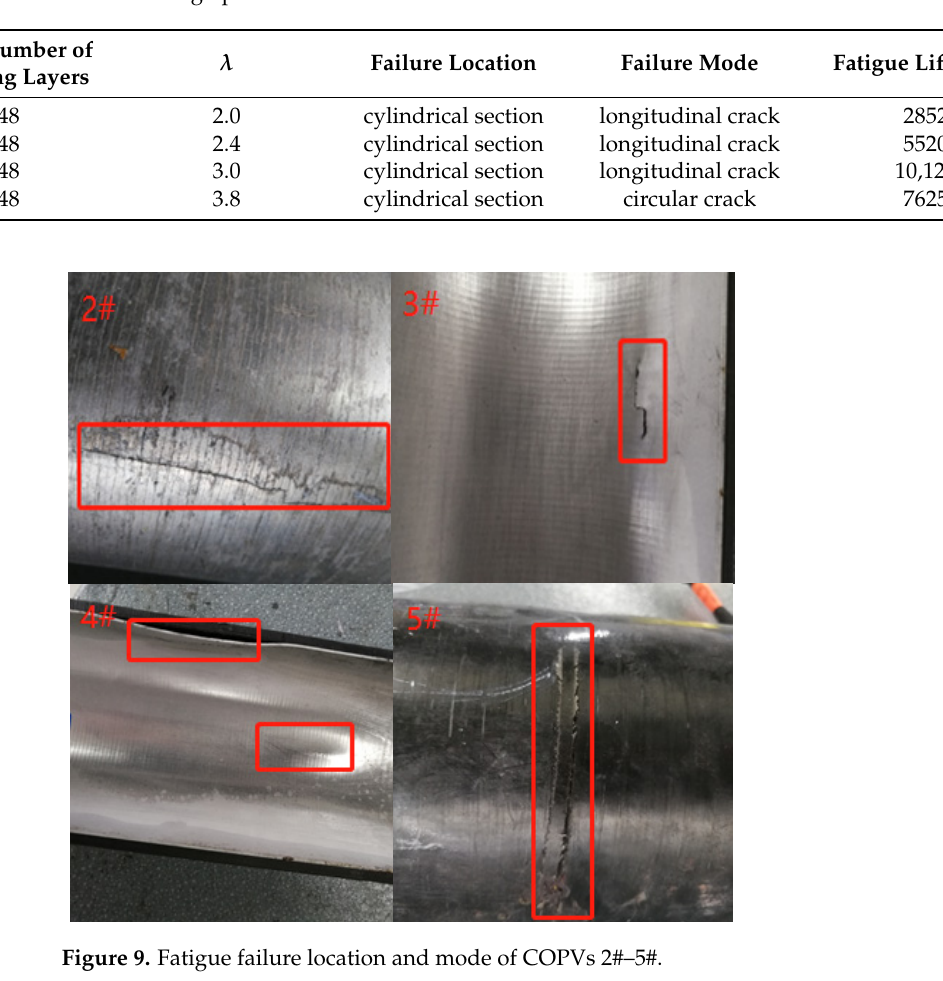
Table 4. Design parameters and test results of COPVs 2#–5#.